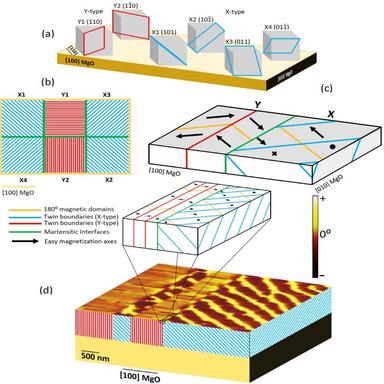
Schematic representation of the twinning configurations in Ni-Mn-Ga epitaxial films on (001) MgO: a) Possible twinning planes related to the six -planes of the austenitic cells (X-type in blue and Y-type twinning configuration in red). b) Simplified plan-view of the colonies of twinning configurations (blue and red lines), separated by the martensitic interfaces (green lines). c) Simplified 3D slice of X- and Y-type configurations of twins (blue and red lines) cut along MgO. Martensitic interface (green li